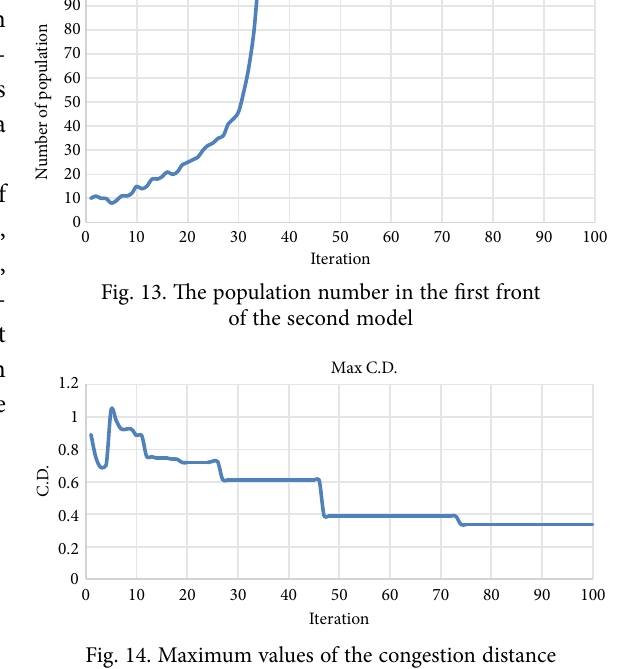
Fig. 14. Maximum values of the congestion distance in the second